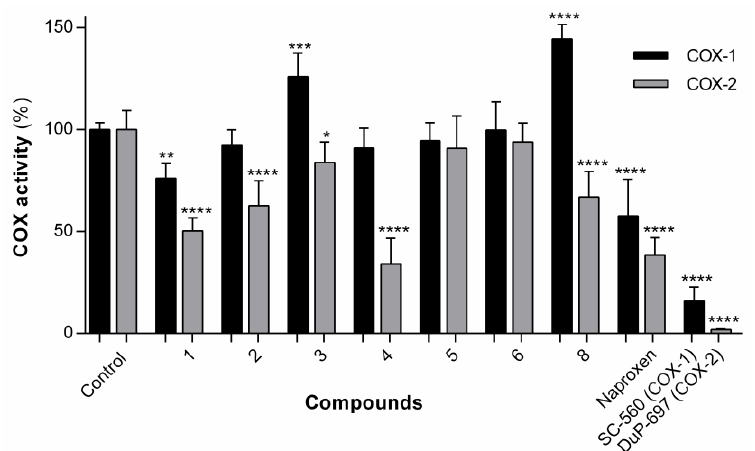
Figure 6. COX-1 and COX-2 activities in the presence of compounds 1 – 6 and 8 at 25 µM. Values are shown with mean ± SD. * p ≤ 0.05; ** p ≤ 0.01; *** p ≤ 0.001, **** p ≤ 0.0001. The